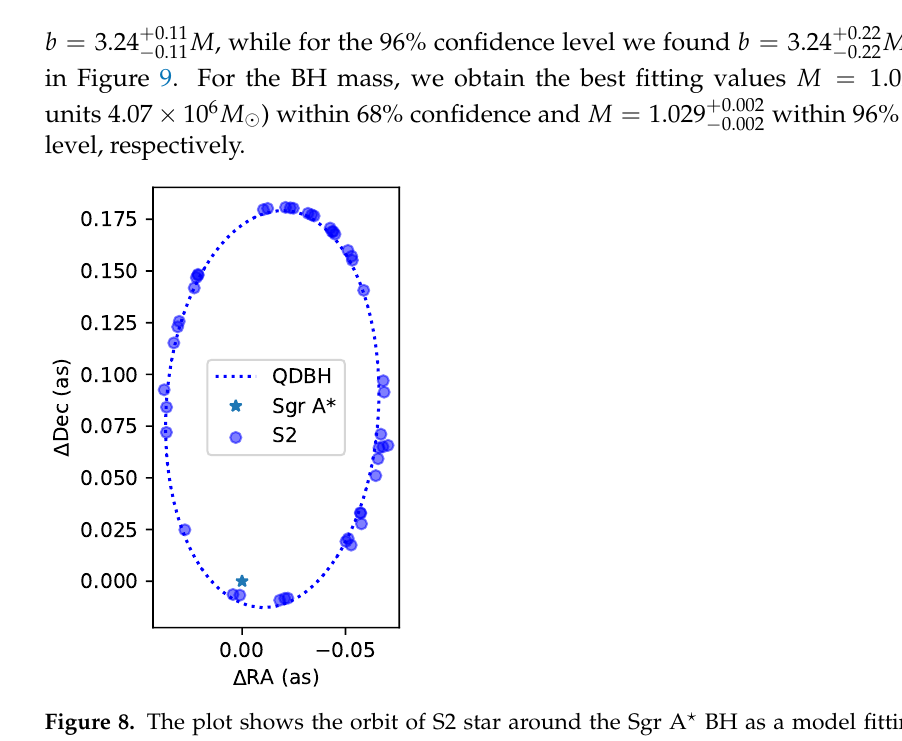
within 96% confidence − 0.002